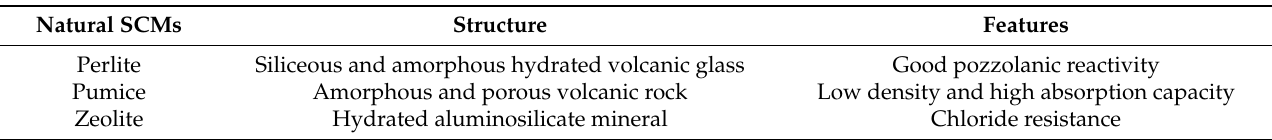
Table 1. Examples of natural supplementary cementitious materials (SCMs) [40]. Natural SCMs Structure